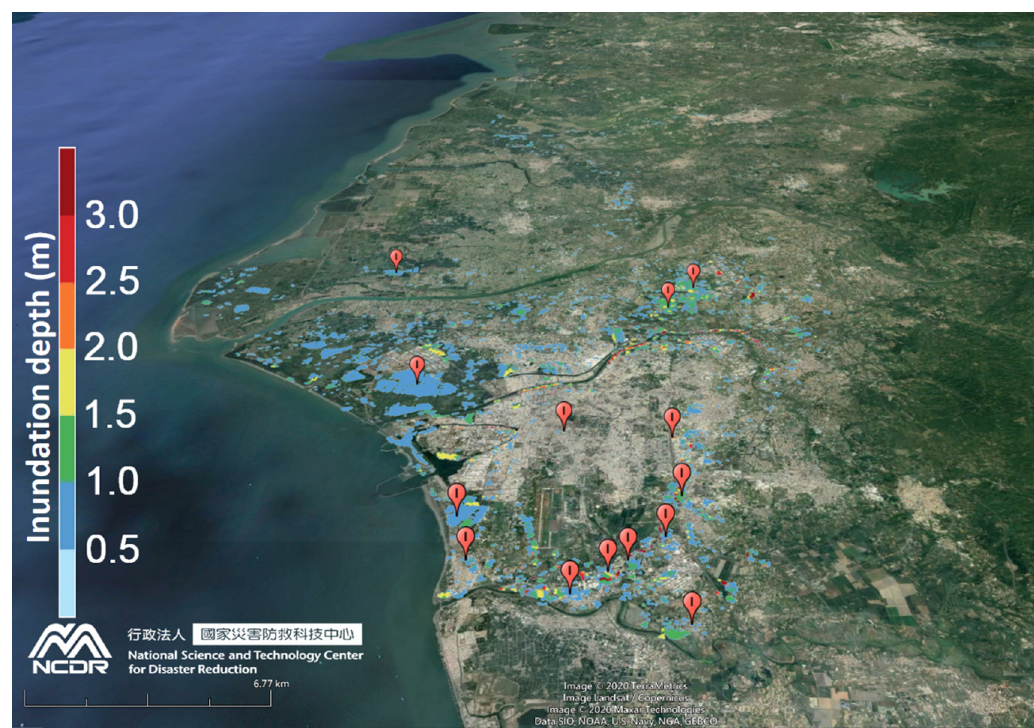
Figure 12. Comparison of the flood locations between the forecasts and reports induced by intense rainfall in Tainan city on 22 May 2020. Areas with colors represent the forecasts by the operational high-performance forecast system for pluvial flash floods, while red points are flooding locations reported by residents.